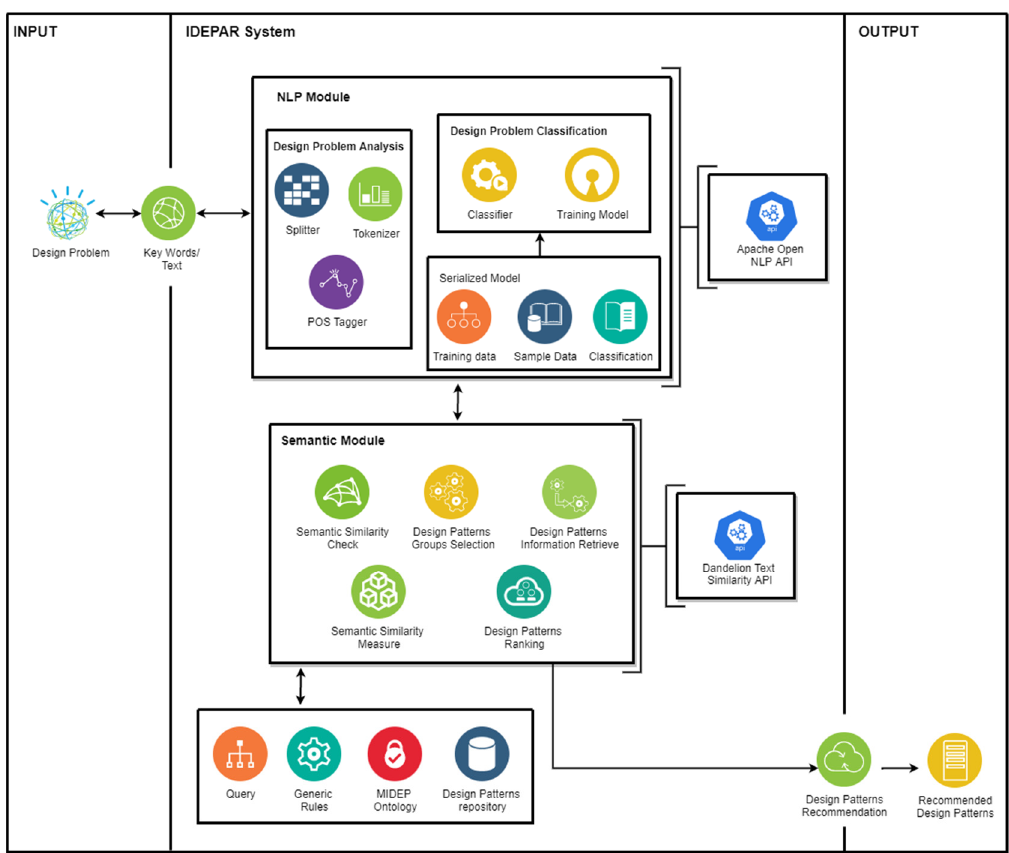
Figure 3. IDEPAR system architecture.